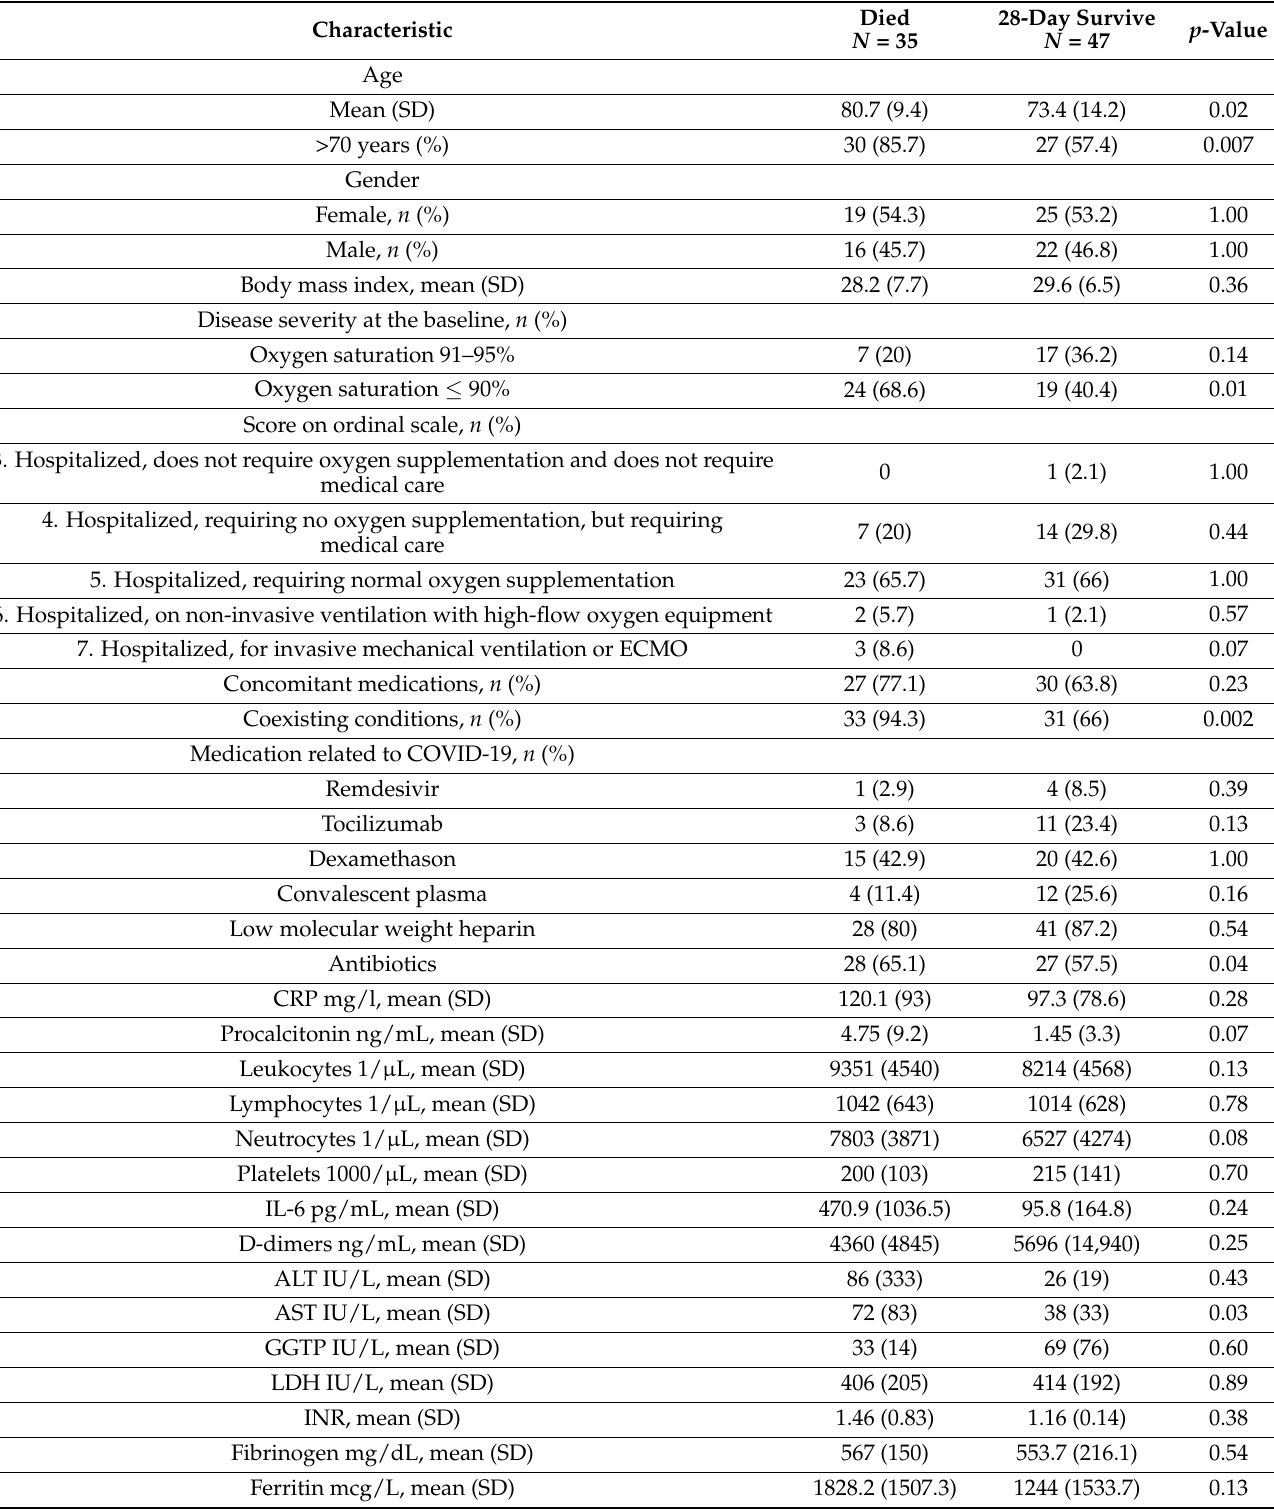
Table 6. Comparison of patients with eGFR < 30 mL/min who died or